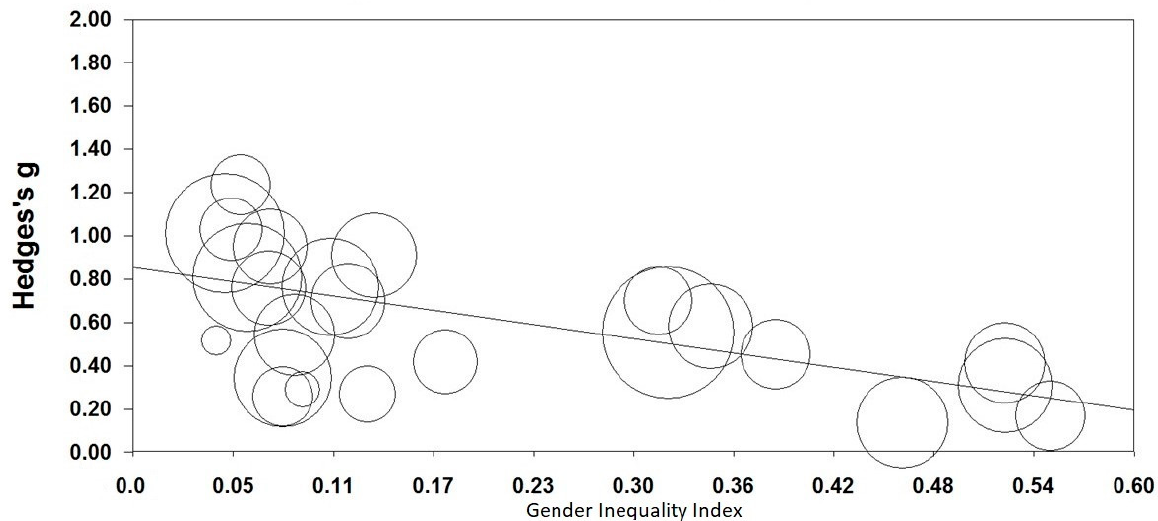
Figure 4. Relationship between gender inequality index and CRAS-S (AWA) scores. Higher scores of Hedge’s g represent a larger gender difference in the CRAS-S scores and higher scores in Gender Inequality Index represent lower gender equality. Animal welfare attitudes (AWA) were measured with the Composite Respect for Animals Scale-Short Version (CRAS-S). Circles represent sample sizes.